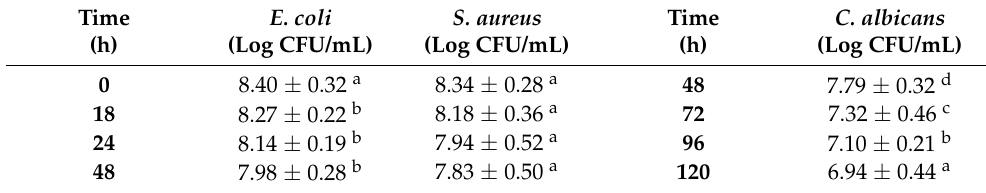
Table 4. Time–kill study of nanohydrogel against Escherichia coli , S. aureus , and Candida albicans